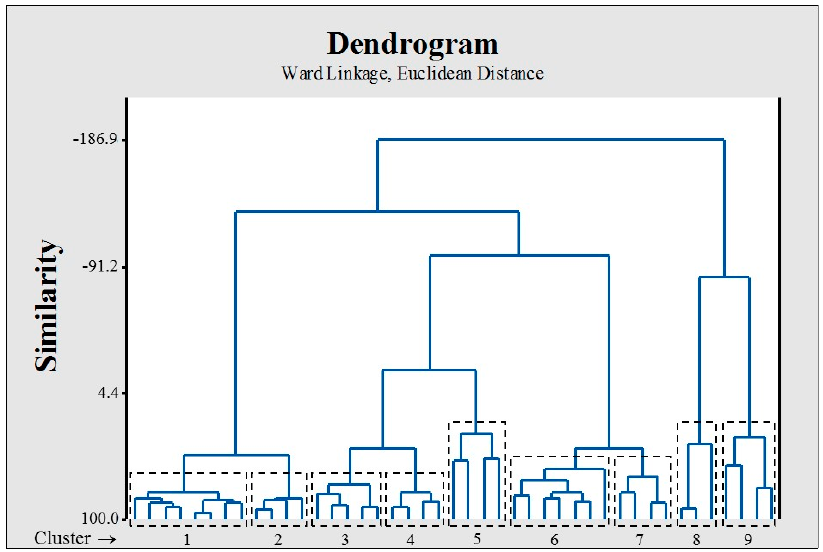
Figure 3. Dendrogram obtained for the graphical representation of the nine clusters used for the training/test set